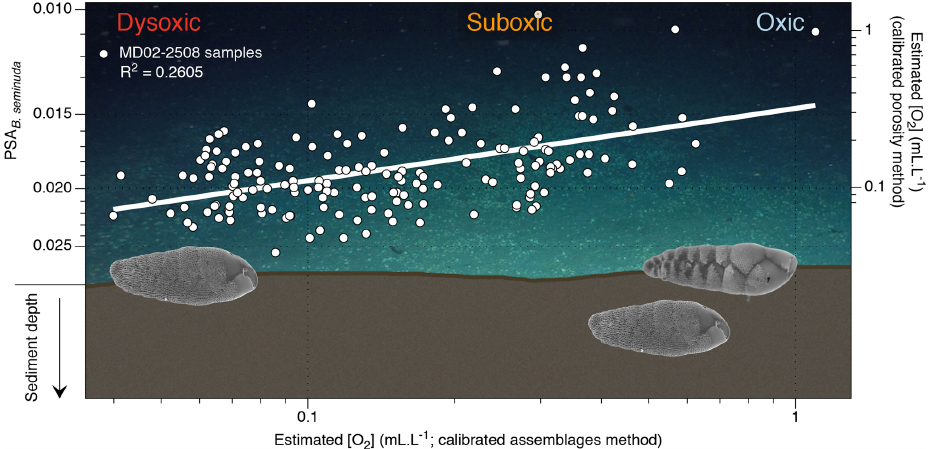
Figure 5. Conceptual graphic of the porosity response of benthic foraminifera ( B. seminuda for the ENP OMZ) to [O 2 ] variations (back- ground image is courtesy of Erik Cordes, Temple University, BOEM Deep Search, USGS, NOAA HOV Alvin 2018, © Woods Hole Oceano- graphic Institution). The plot shows estimated [O 2 ] using the assemblage method vs. estimated [O 2 ] using the porosity method (and corre- sponding PSA values) for Core MD02-2508. Images of B. seminuda show the gradual change in porosity associated with oxygen